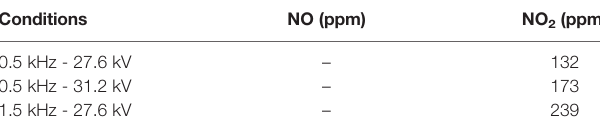
TABLE 2 | Concentration of plasma-generated NO x in the exhaust